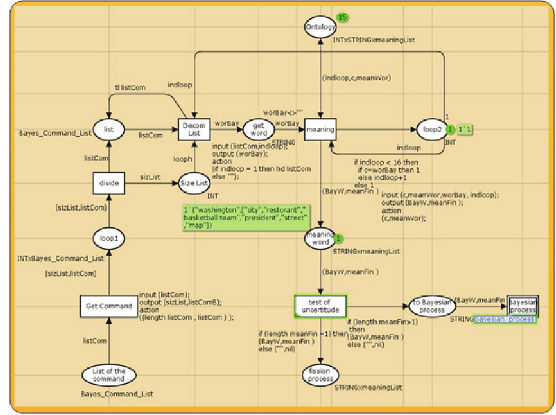
Fig. 13. Process of uncertainty detection